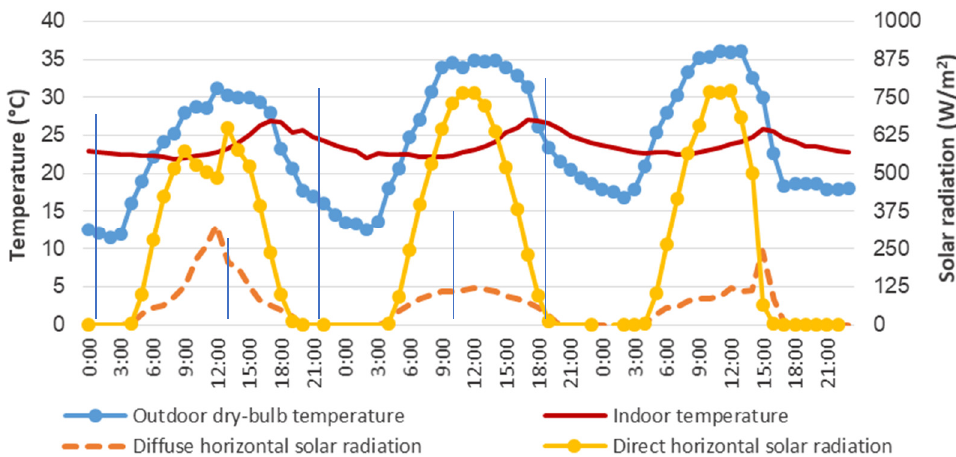
Figure 6. Measured climatic parameters and indoor temperature at 29.6 to 1.7.